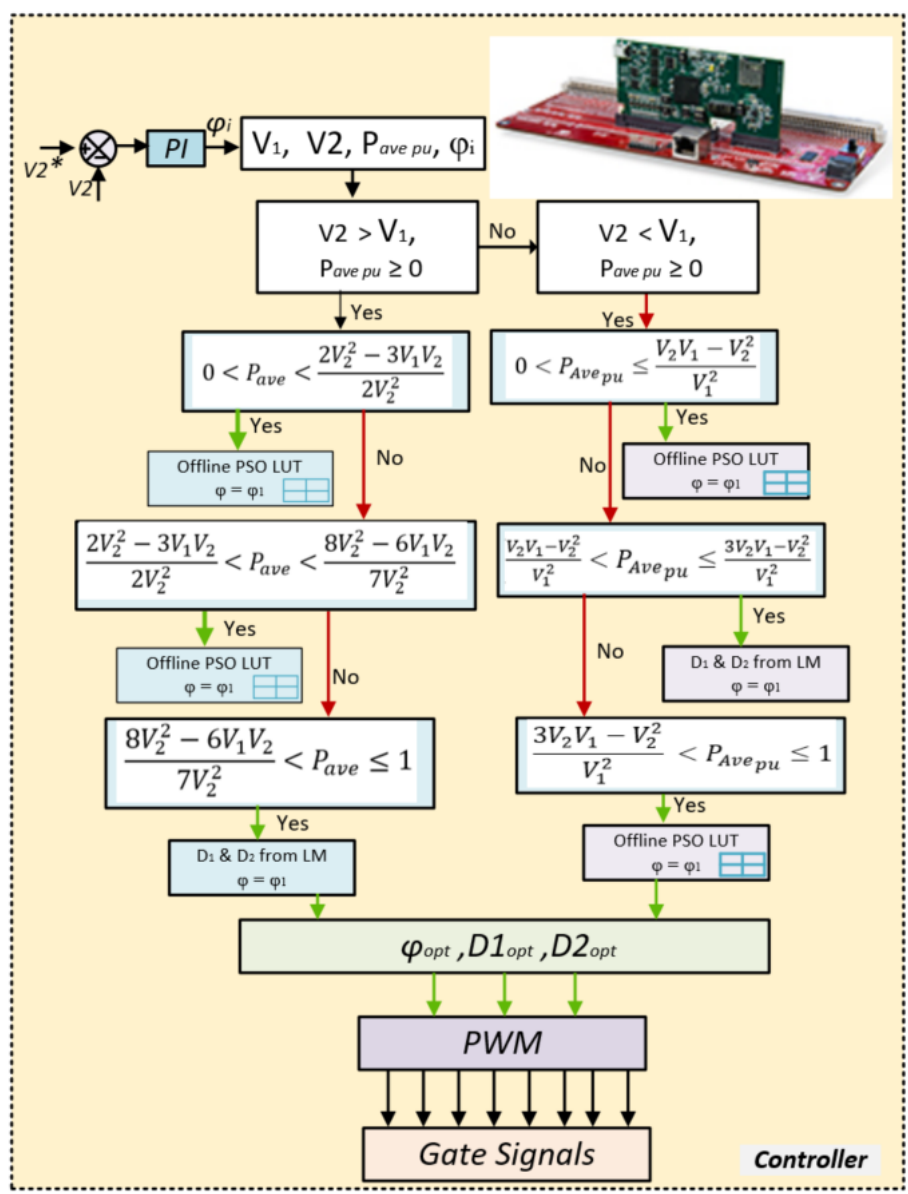
Figure 11. Optimal closed-loop control of the